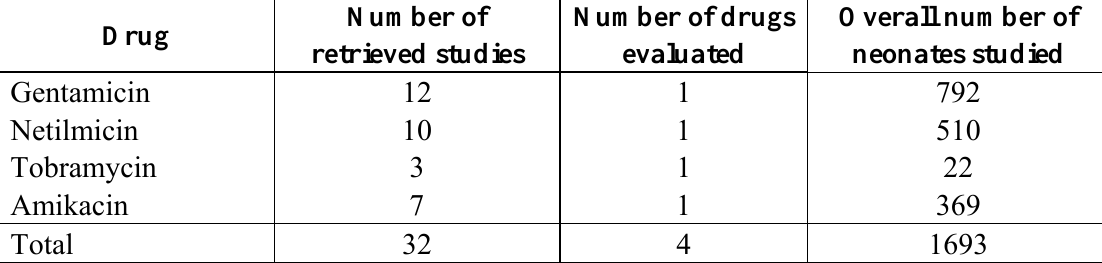
Table 5. Number of retrieved studies and number of drugs